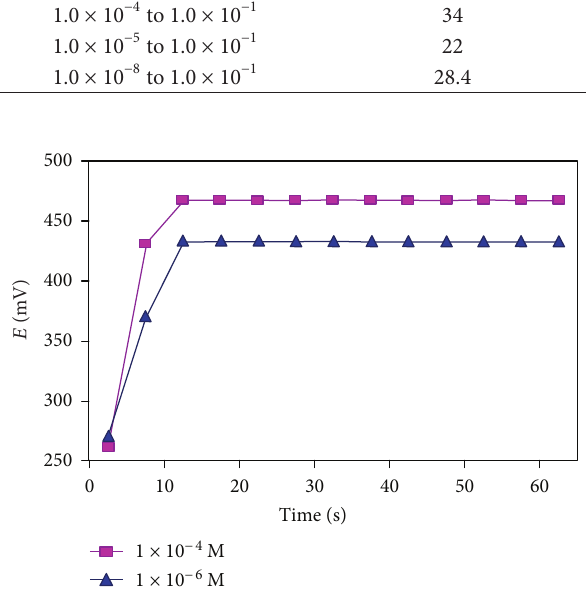
F 4: e effect of the time on potentiometric response of Mg